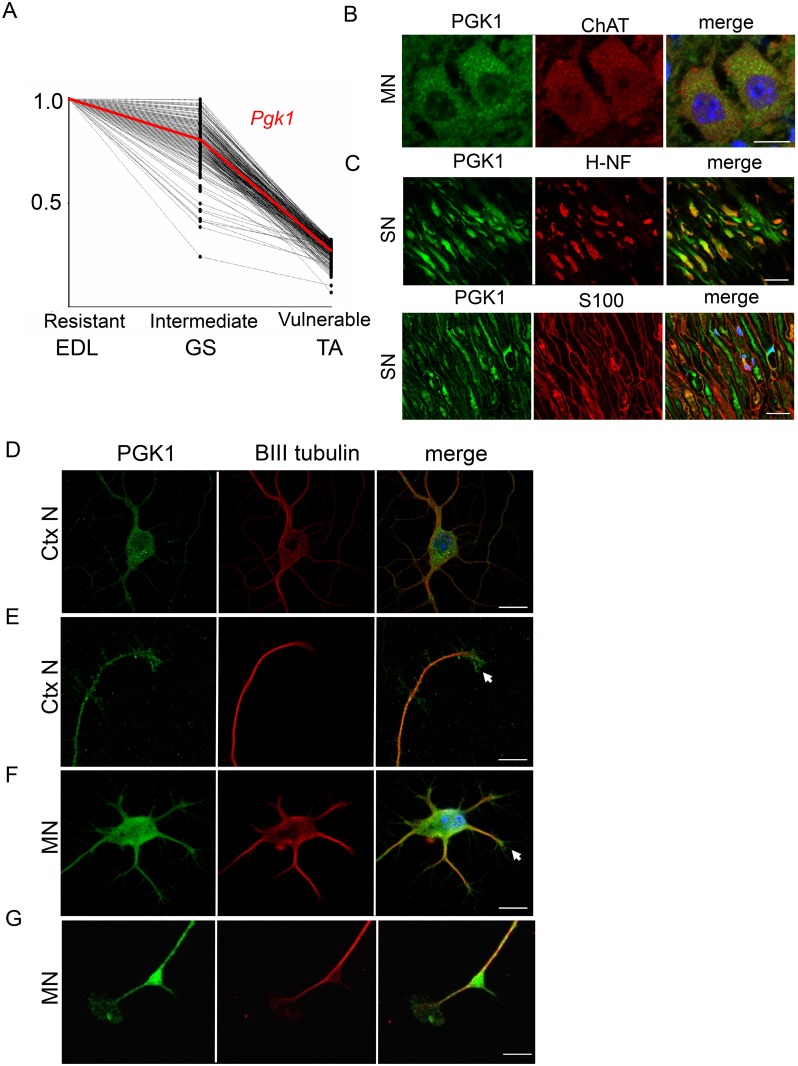
PGK1 is enriched in disease-resistant motor neuron pools, expressed in neuronal cells cellular and axonal compartments in vivo and in vitro.(A) Gene expression profile graph showing transcripts trending across differentially vulnerable motor neuron pools, with PGK1 highlighted. Note that Pgk1 was 5-fold higher expressed in the EDL disease-resistant motor neuron pool compared to the TA vulnerable motor neuron pool, with expression levels trending through the GS intermediate pool. (B) Representative confocal micrographs showing expression of PGK1 in the cytoplasm of motor neurons (MN) in mouse spinal cord. Scale bars = 20 μM. (C) Expression of PGK1 was also detected in the majority of axons in the sciatic nerve (SN), being localised alongside neurofilament (H-NF; upper panels) but not co-localising with glial S100 label (lower panels). Scale bars = 5 μM (D) In vitro analysis showed expression of PGK1 in the cell body and axonal processes of mouse cortical neurons (CtxN). Scale bars = 30 μM. (E) Expression of pgk1 was detected in the axonal nerve terminals of mouse cortical neurons (CtxN). Scale bars = 15 μM. (F) Expression of PGK1 was also found in mouse primary motor neuron (MN) cell bodies and axonal compartments (arrow). Scale bars = 30 μM. (G) Expression of Pgk1 in the axonal terminals/growth cones (arrow) of mouse primary motor neurons (MN). Scale bars = 15 μM.